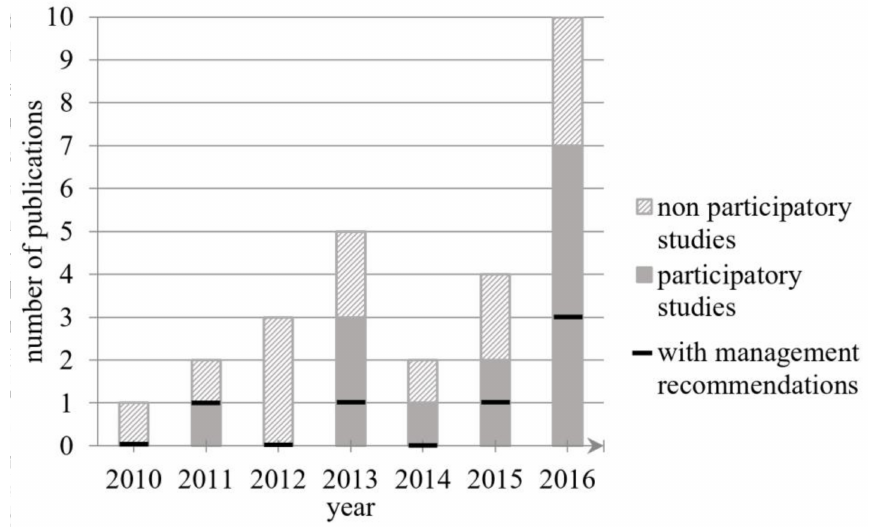
Figure 2. Yearly distribution of Web of Science articles assessing ES in mining regions ( n = 26). 50% of selected articles used a participatory approach, and only 20% provided management recommendations. No articles fitting our scope were found for the 2000s